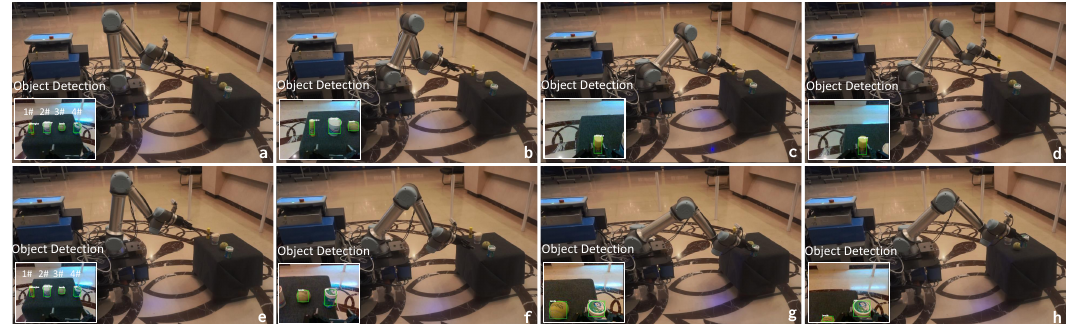
Figure 12. The process of multi-object grasping. ( a ) Detecting the multiple objects(1# yellow glue, 2# paper cup, 3# tennis, 4# yida). ( b ) Approaching the 1# object. ( c , d ) Grasping the 1# object. ( e ) Detecting the 4# object. ( f ) Approaching the 4# object. ( g , h ) Grasping the 4# object.